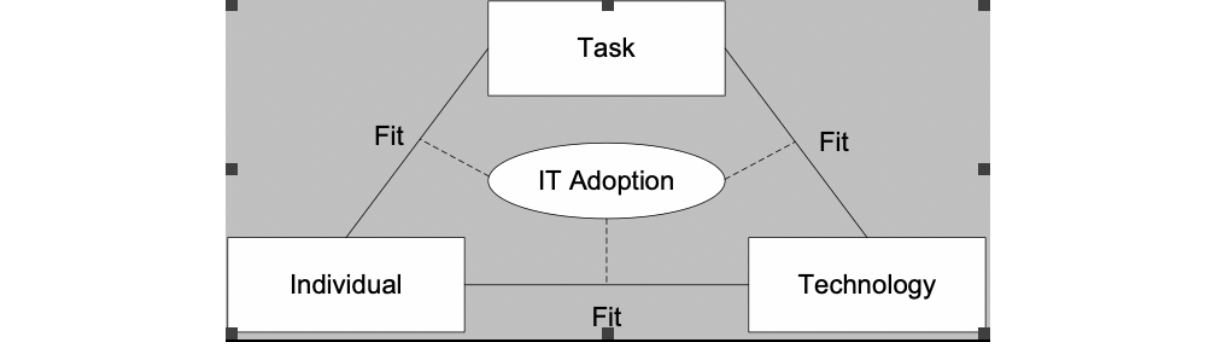
Figure 1. The FITT-framework of information technology (IT) adoption (Ammenwerth, 2006); FITT: fit between Individual, Task, and Technology.